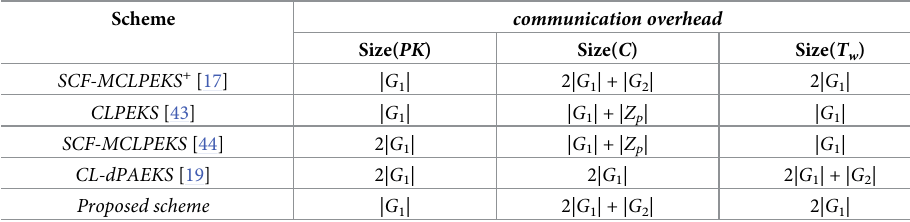
Table 2. Comparison of communication